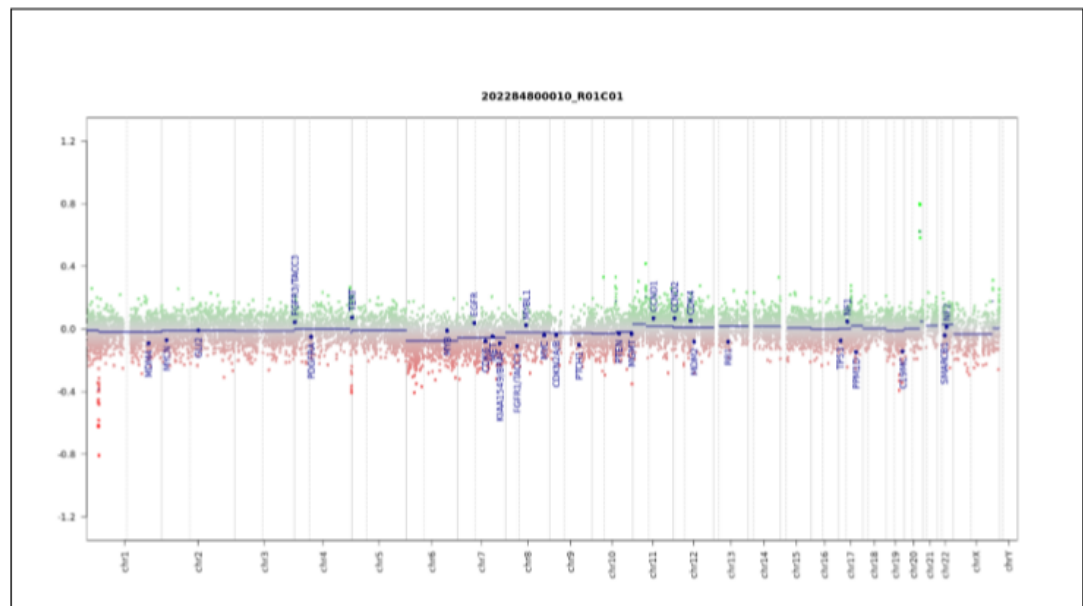
Figure 4. Copy number variation (CNC) profile analysis. Depiction of structural rearrangements involving autosomes and X/Y chromosome. Gains/amplifications represent positive (green) and losses represent negative (red) deviations from the baseline. Twenty-nine tumor relevant genomic regions are highlighted.